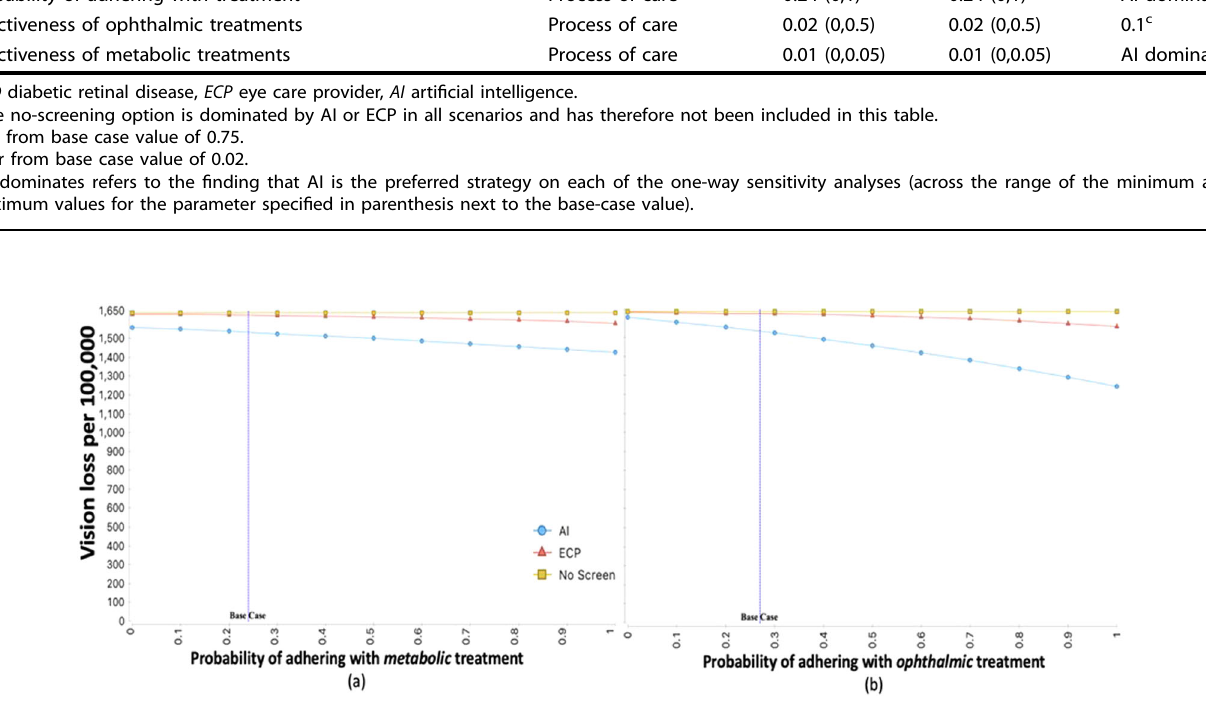
Fig. 1 Expected vision loss per 100,000 vs probability of adhering with treatment for each screening strategy. a , b Show that as the adherence with recommended metabolic and ophthalmic treatments increases the number of patients with vision loss per 100,000 decreases for both the eye care provider (ECP) and arti fi cial intelligence (AI) screening strategies. However, the decrease in number with vision loss is more marked for the AI vs ECP screening